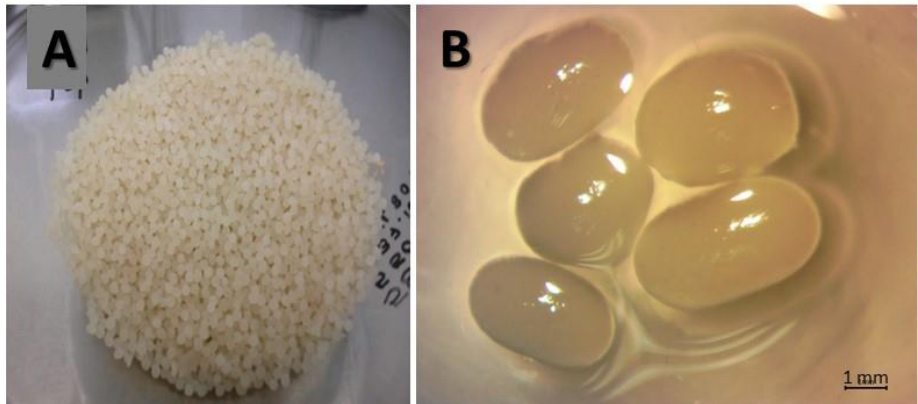
Figure 5. Immobilized biomass in calcium alginate capsules. ( A ). Filtered alginate capsules, ( B ). Size and form of fresh capsules.